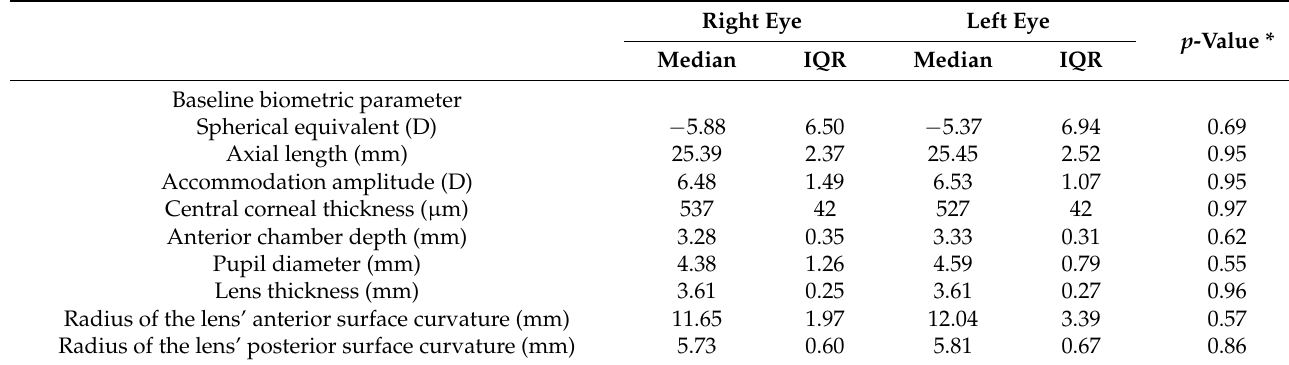
Table 1. Baseline biometric parameters of both eyes before instillation of 0.01% atropine eye drops.